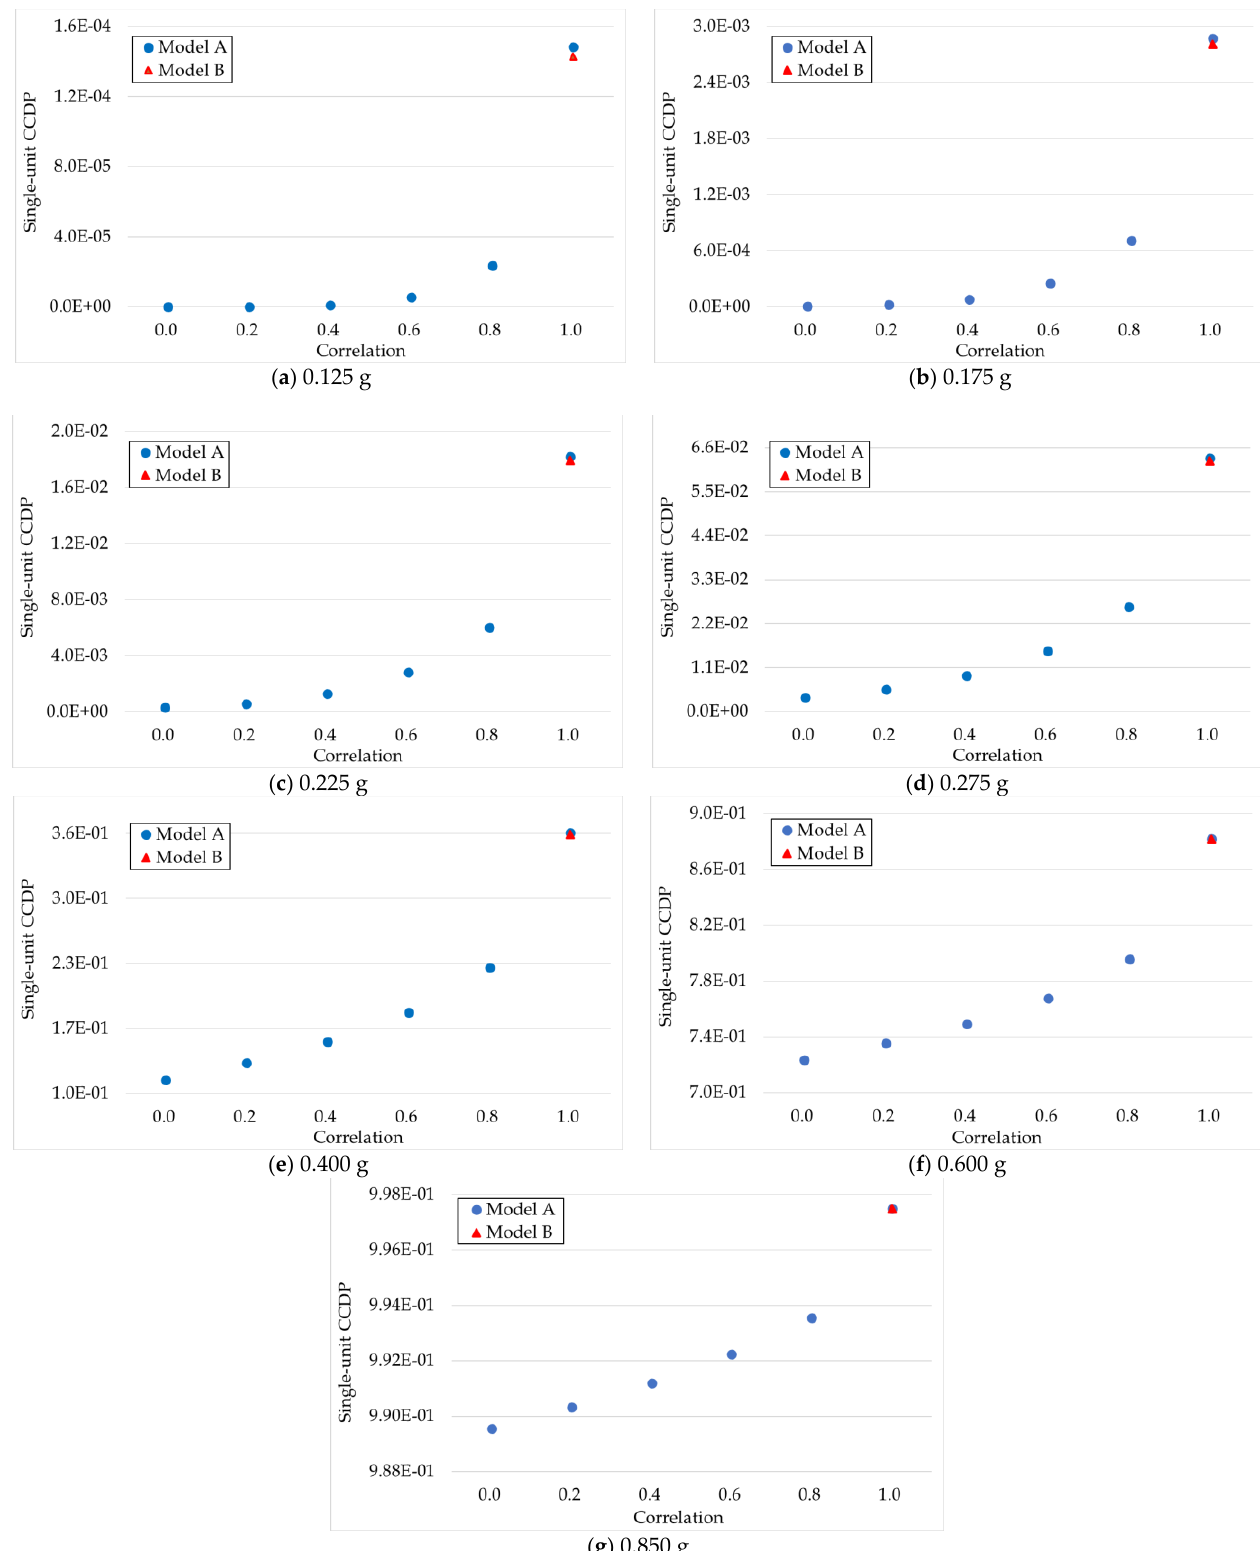
Figure 12. Plots of SUCDF versus seismic correlation.